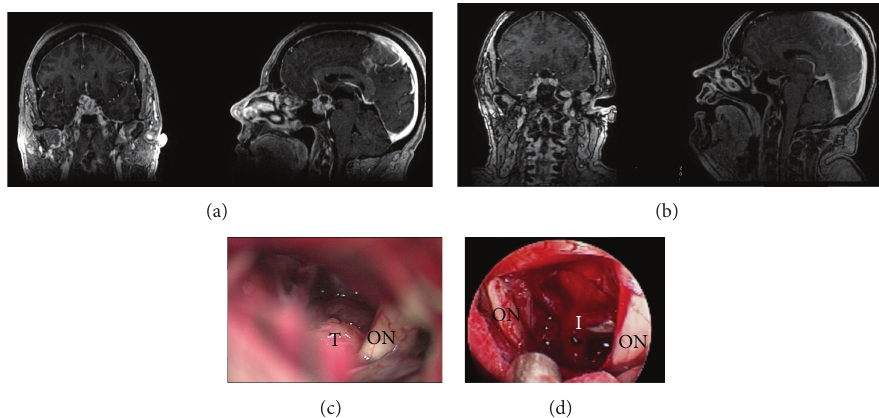
Figure 3: (a) Preoperative and (b) postoperative MR images of a heterogeneously enhancing cystic mass involving the sella and suprasellar region. Pathology was consistent with craniopharyngioma. Near-total resection was achieved. (c) Microscopic images from surgery demon- strateopticnerve(ON)anditsrelationshiptotumor(T).(d)Comparisonimagefromendoscopicviewinthesamepatientnowdemonstrating both optic nerves (ON) and infundibulum (I) following tumor resection. Note the wider field of view, greater visibility, and contrast at depth. There is also significantly less blur from anatomy obscuring view superficial to focal point as clearly noted in microscopic image (c).